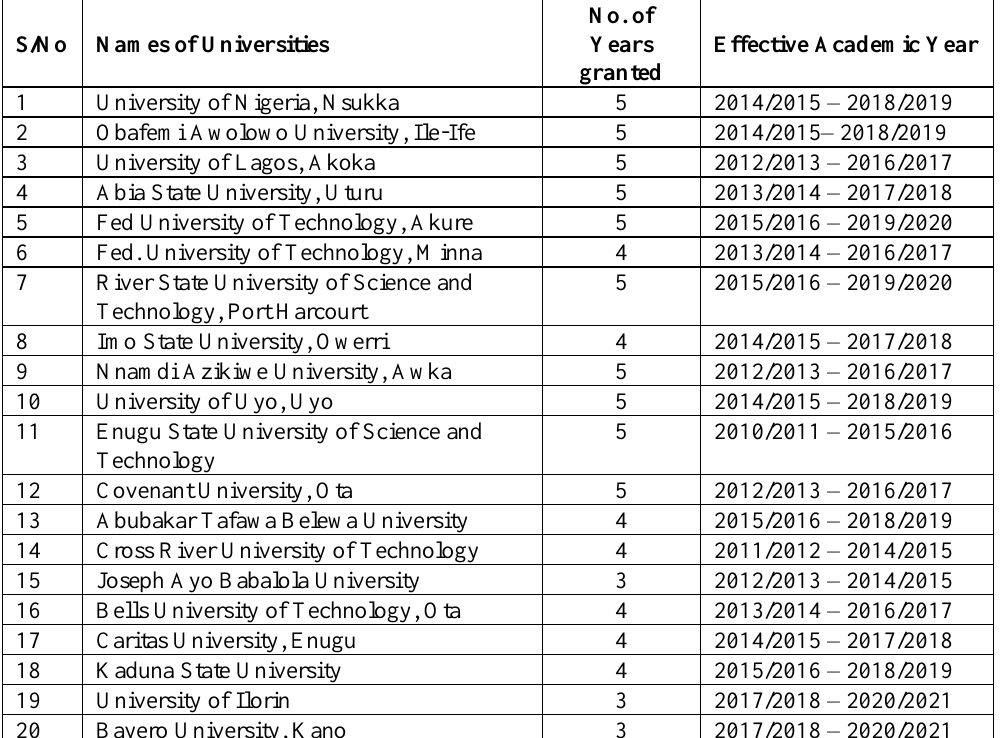
Table 4. Accredited Universities for Estate Management Courses (Estate Surveyors and Valuers Registration Board of Nigeria,